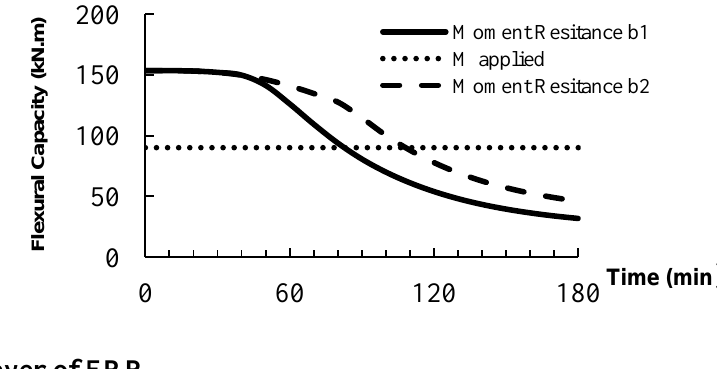
Figure 6. Model prediction for tests of the beams tested by Abbasi et al.